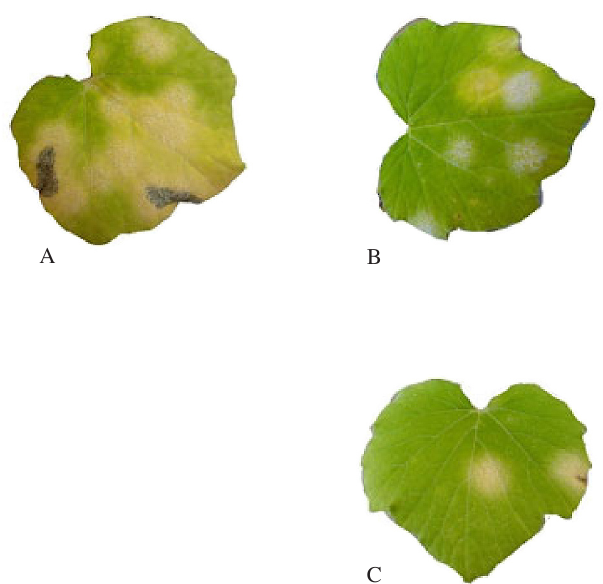
Fig. 2: Comparison of infected squash leaves exposed to powdery mildew seven days post inoculation. A; control, B; primed squash leave with 2 mM BABA, C; primed squash leave exposed to 4 mM BABA.